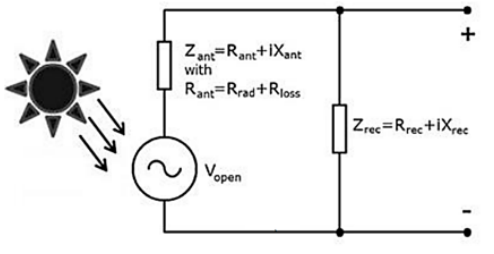
Figure 6. Equivalent circuit for the rectenna system (adapted from the work in [5]). V open is the voltage generated by the receiving antenna at its open terminals, while V rec is the voltage seen at the terminals when a current is flowing to the rectifier. The useful power is the power going to the impedance of the rectifier Z rec and it is given by expression